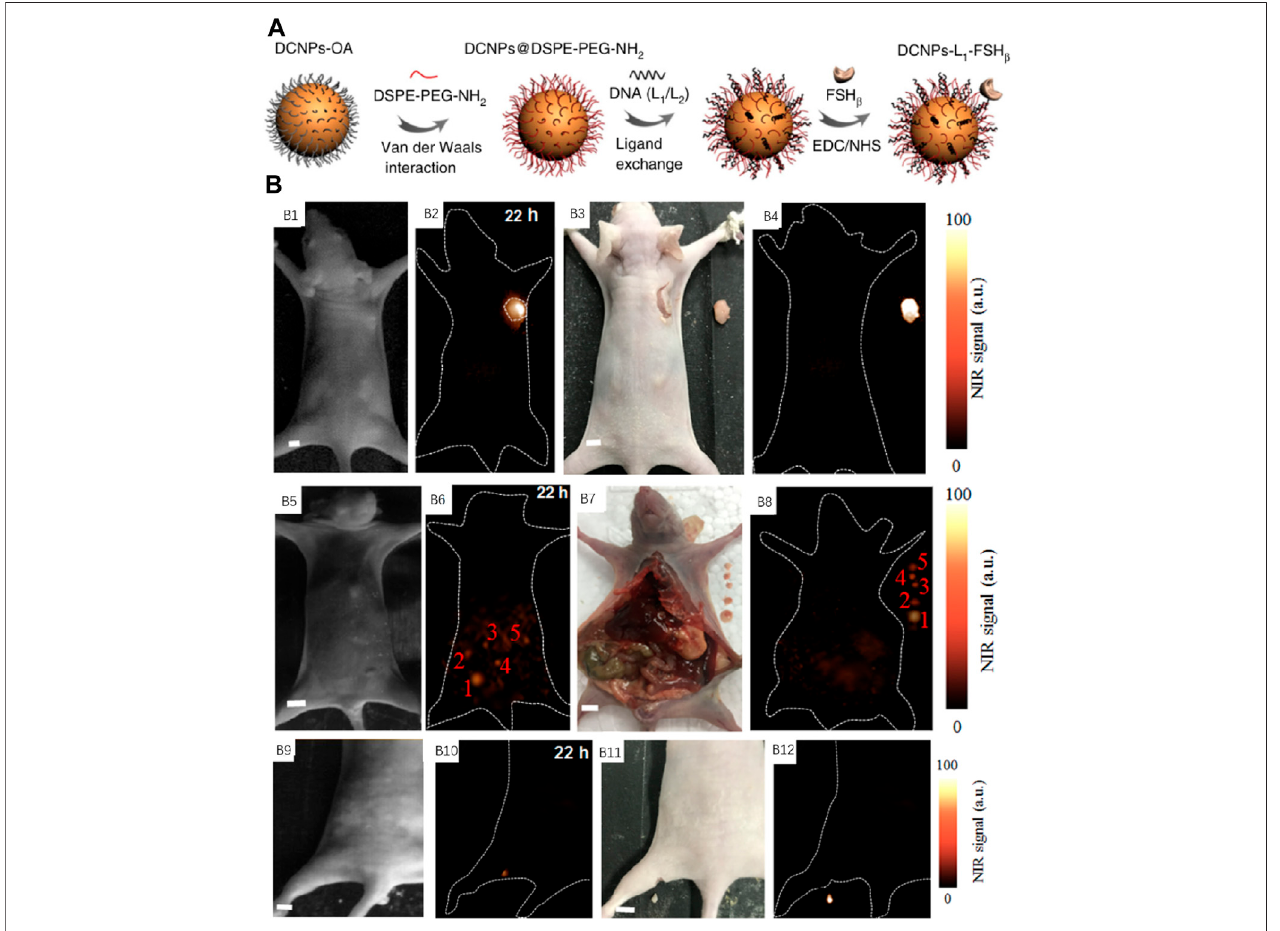
FIGURE8|(A) SchematicexplanationofNIR-IInanoprobefabrication. (B) NIR-II fl uorescenceimage-guidedresection.NIR-II fl uorescencebioimagingresultofthe epidermal tumor (B1,B2) , digital image (B3) and NIR-II fl uorescence bioimaging result (B4) after surgical resection. The NIR-II fl uorescence bioimaging result of peritoneal metastases (B5,B6) , digital image (B7), and NIR-II fl uorescence bioimaging result (B8) after surgical resection. The NIR-II bioimaging outcomes of popliteal lymph node metastasis (B9,B10) . Digital image (B11) and NIR-II fl uorescence bioimaging result (B12) after surgical resection. Adapted with consent from Wang et al.